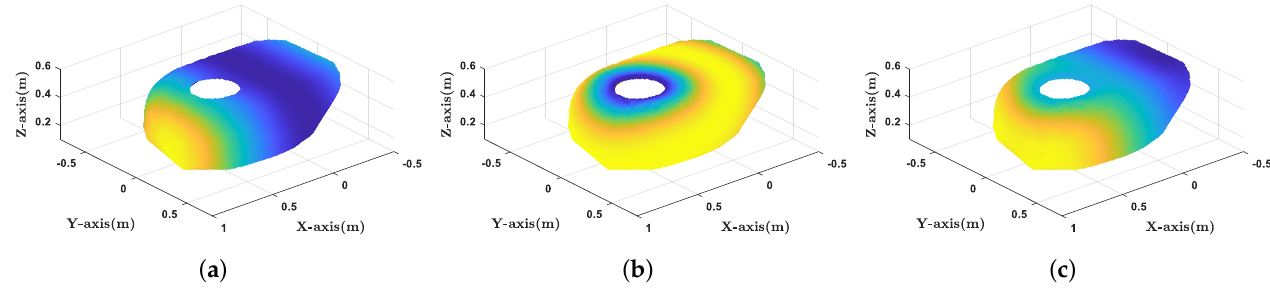
Figure 5. All the points in DBB 1 are colored depending on ( a ) the determinant value in (7), ( b ) the reachability in (9), and ( c ) the score in (10) (yellow: high, blue: